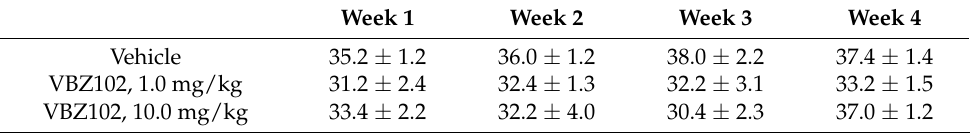
Table 1. Effects of the orally administered VBZ102 on body weight (g) after 28 days of treatment.